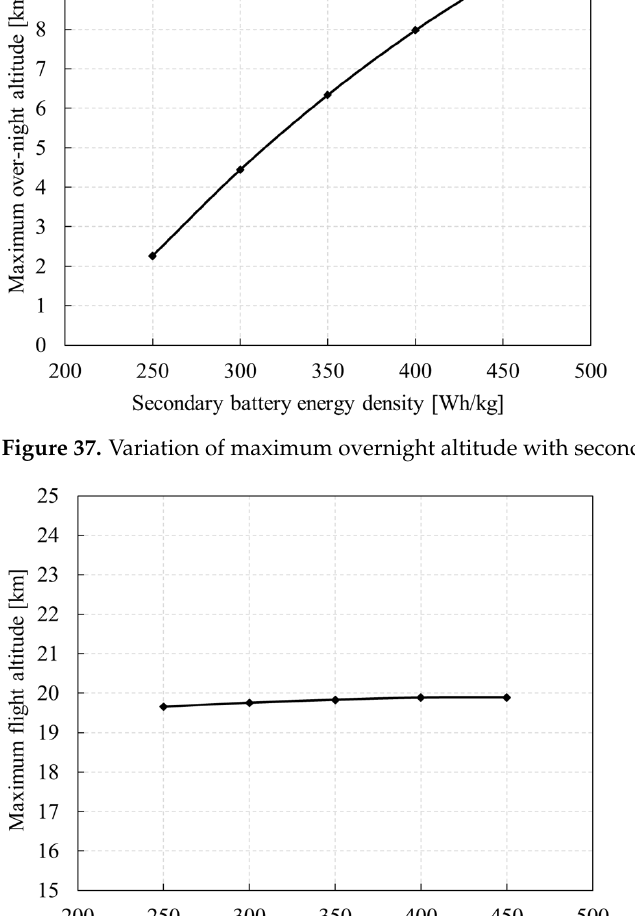
Figure 37. Variation of maximum overnight altitude with secondary battery energy density.